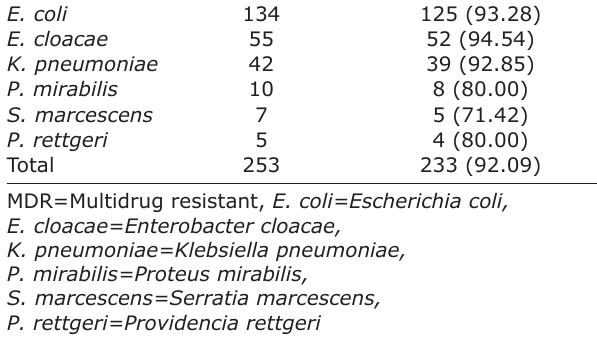
Table-2: Enterobacteriaceae isolates tested by PCR for the determination of qnr determinants. Strain